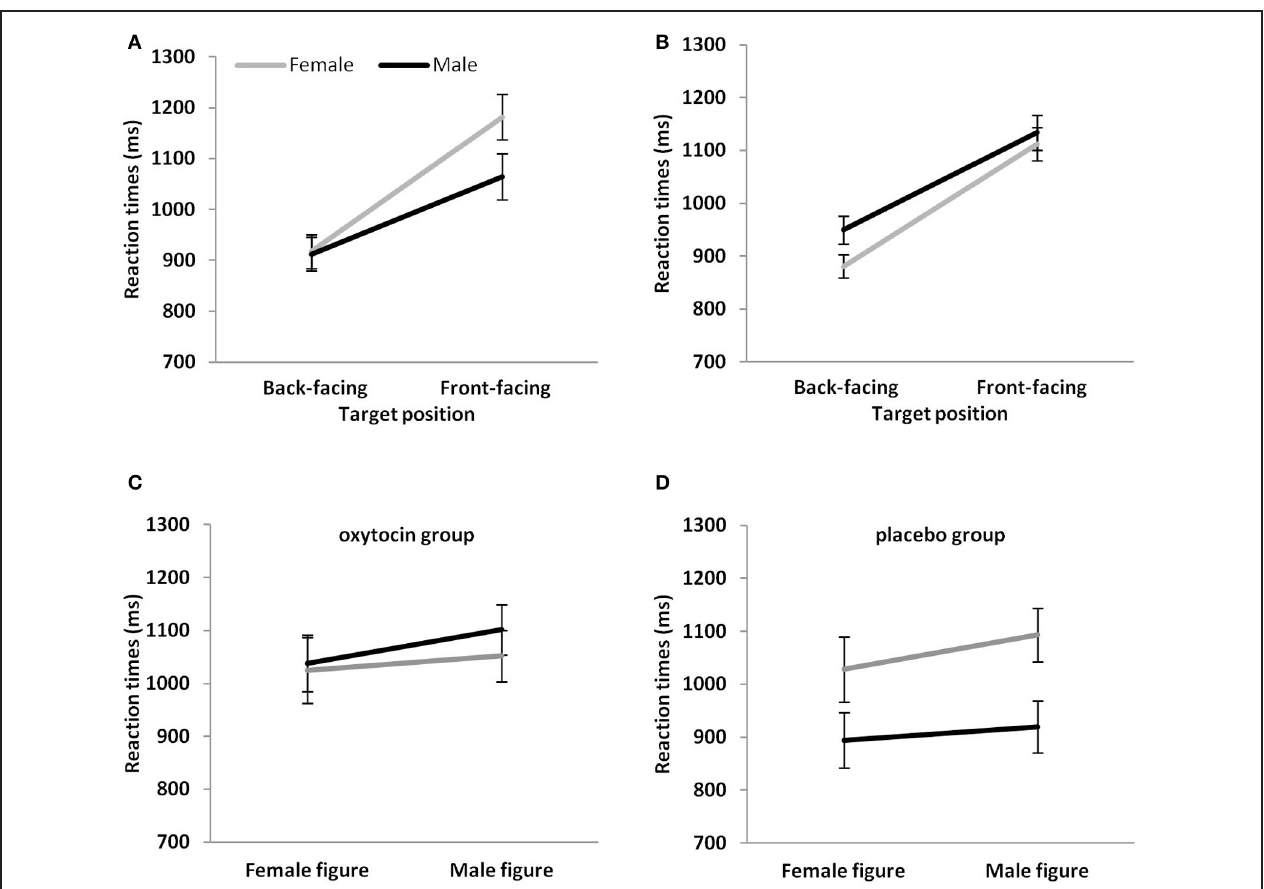
FIGURE 2 | Mean reaction times (A) of male and female participants to target figures in the back- and front-facing position, (B) to male and female target figures in the back- and